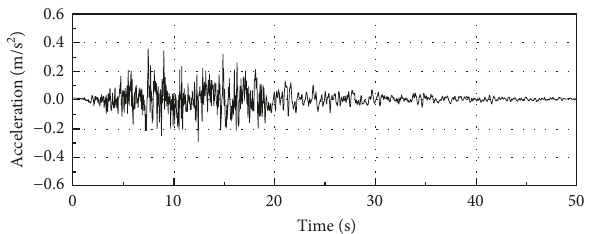
Figure 5: Earthquake acceleration time-history curve of intensity 7 frequently of synthesized (longitudinal input).